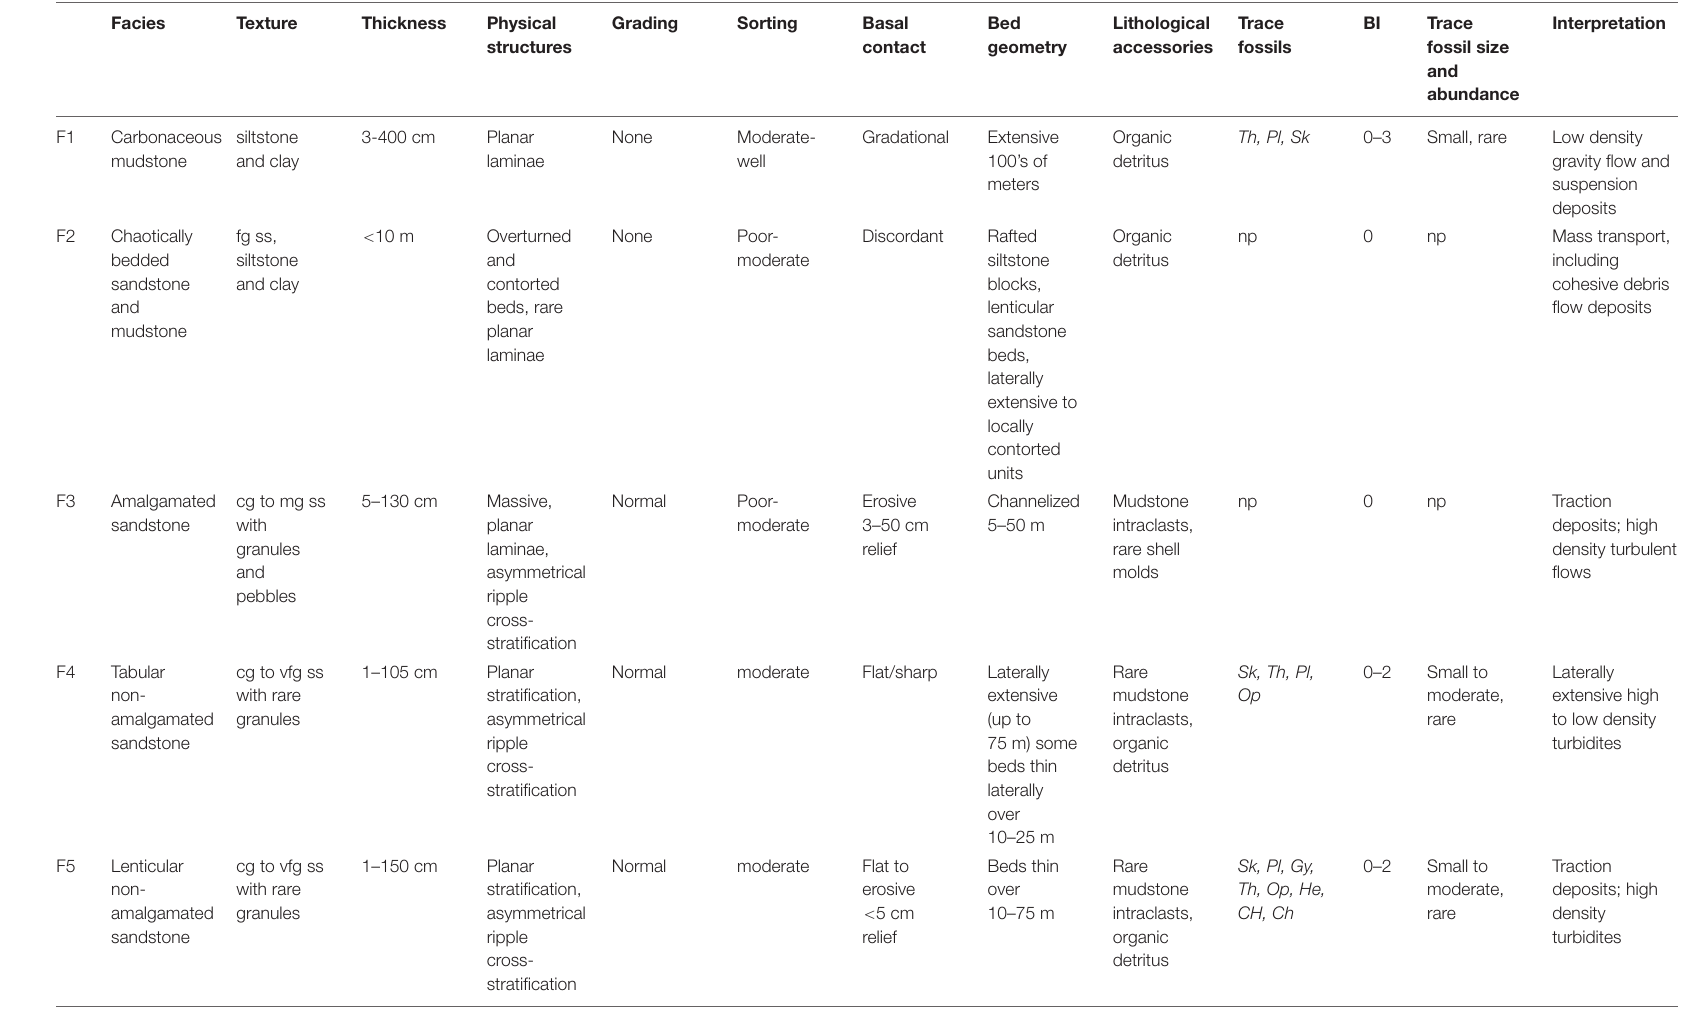
TABLE 1 | Facies of the Tres Pasos and Dorotea formations at Cerro